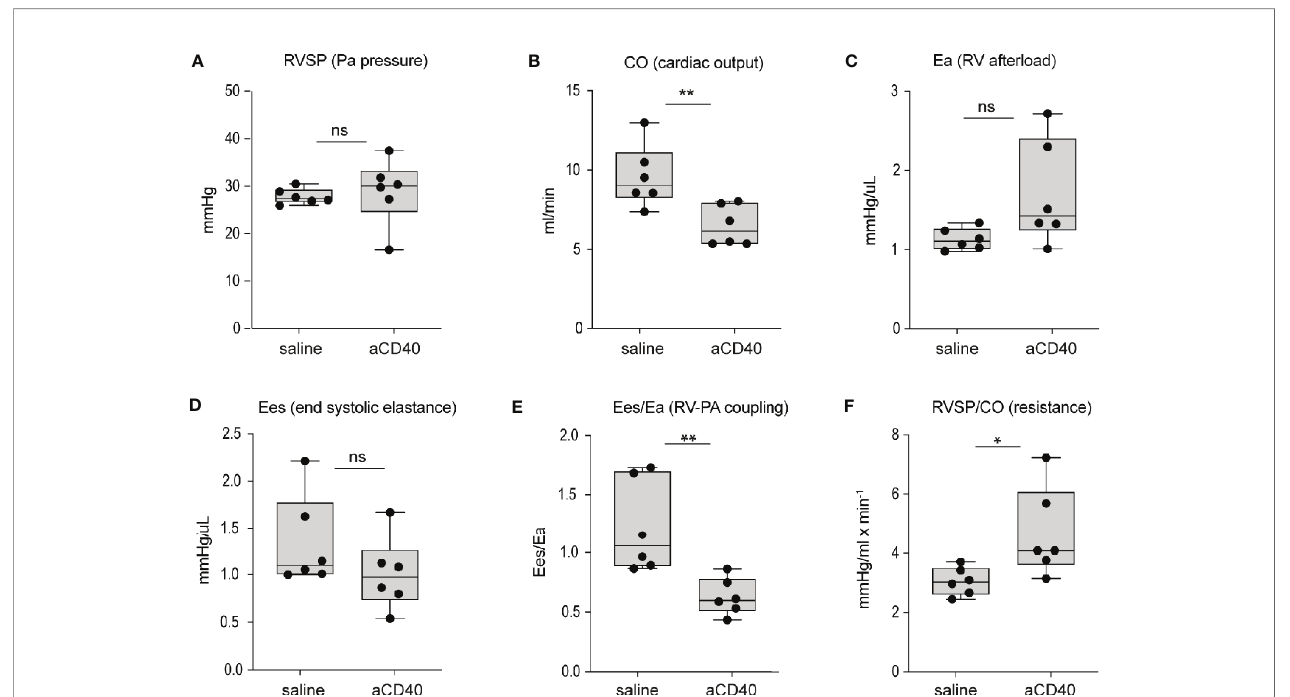
FIGURE 3 | Hemodynamic changes after anti-CD40 administration in sickle cell mice. Cardiovascular parameters in sickle cell mice following saline (control) and anti-CD40 antibody dosing. (A) RSVP - pulmonary arterial pressure (p=0.723, n=6). (B) CO - Cardiac Output (p= 0.0089**, n=6). (C) Ea - Right ventricular (RV) afterload (p=0.0652, n=6). (D) Ees - end systolic elastance (p=0.2257, n=6). (E) Ees/Ea - RV to pulmonary artery (PA) coupling (RV-PA) (p=0.0069**, n=6). (F) RVSP/ CO - RV systolic pressure (SP) divided CO (p=0.0312*, n=6). Right ventricular wall stiffness was also signi fi cantly greater (p=0.039*, n=6) in anti-CD40 compared to control sickle cell mice (data not shown). ** p < 0.01, * p < 0.05, all comparisons between control (saline) and anti-CD40 dosed SCD mice were conducted by a two- tailed student ’ s t -test with signi fi cance set at a signi fi cance of